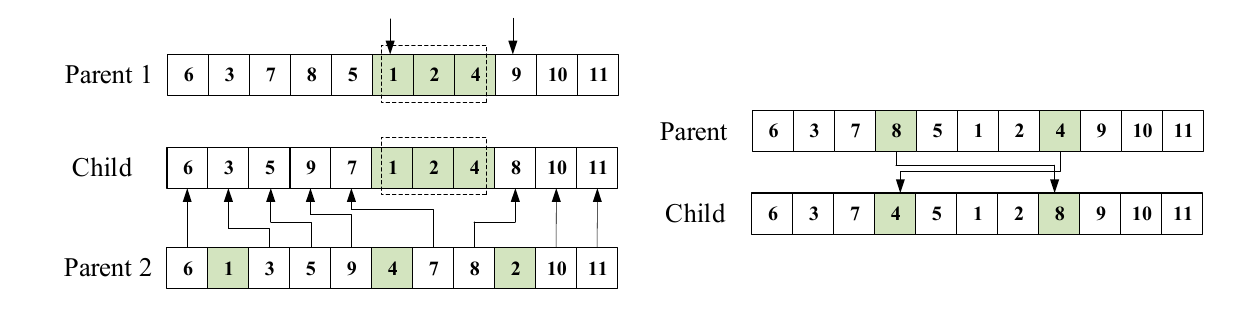
Figure 8. The genetic operators of chromosome.